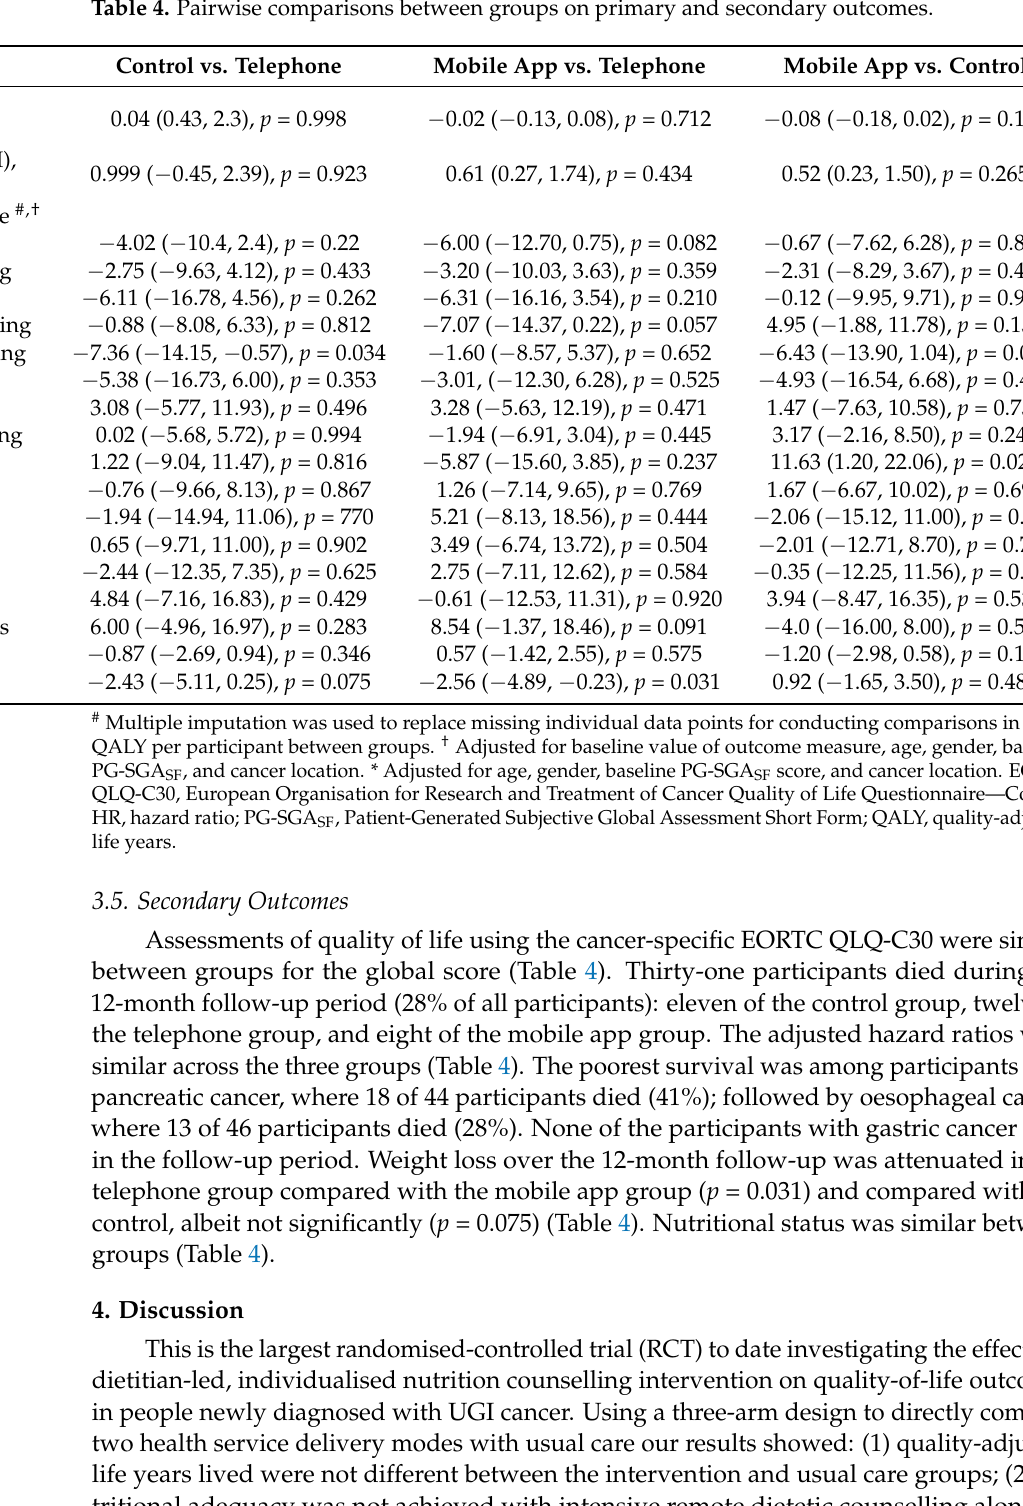
Table 4. Pairwise comparisons between groups on primary and secondary